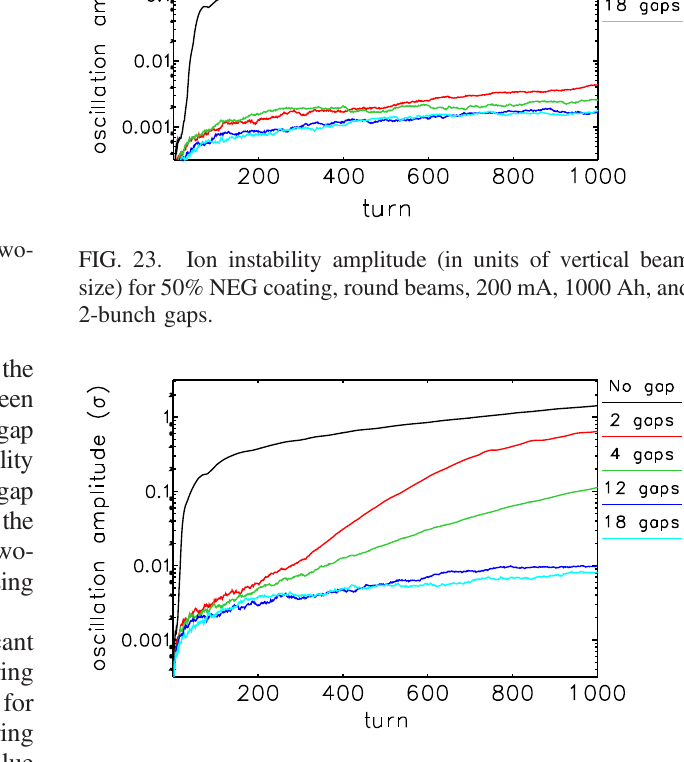
FIG. 24. Ion instability amplitude (in units of vertical beam size) for 50% NEG coating, round beams, 200 mA, 100 Ah, and 2-bunch